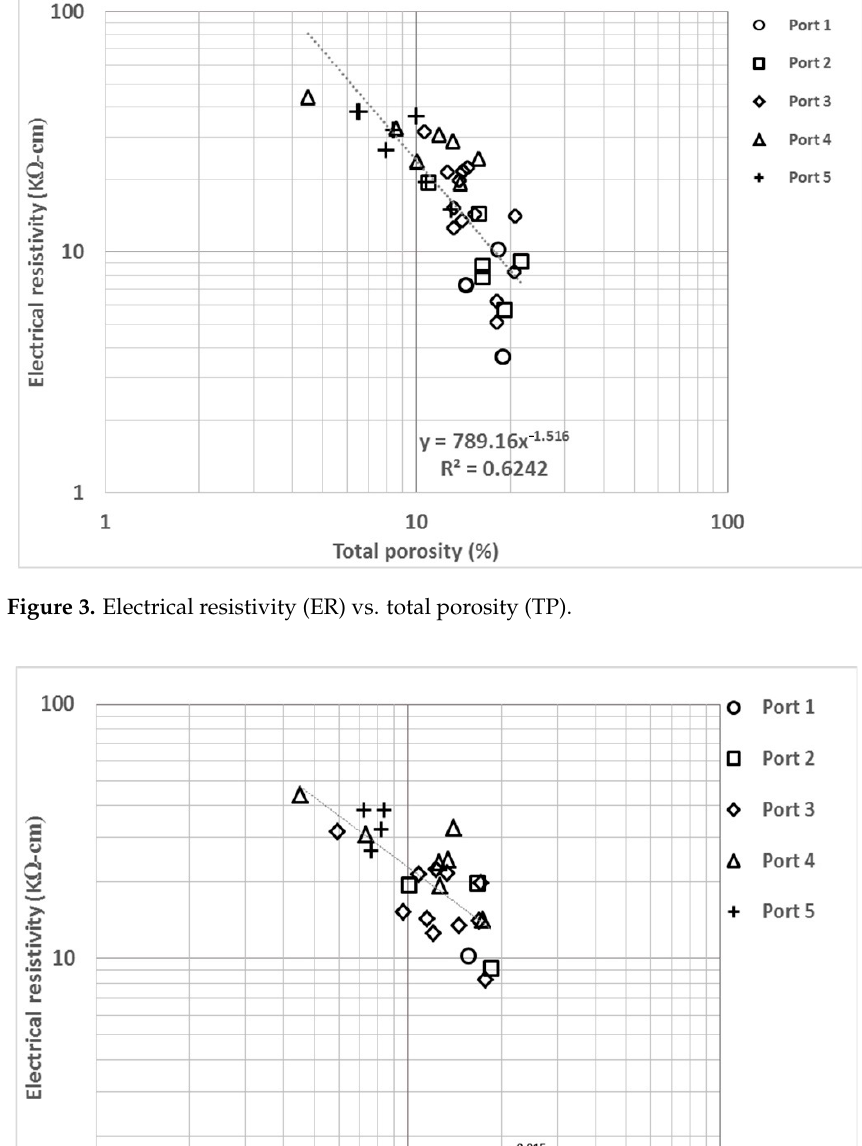
Figure 3. Electrical resistivity (ER) vs. total porosity (TP).